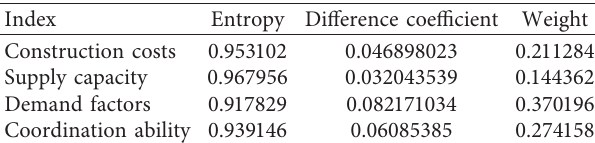
Table 2: Entropy and weight of each